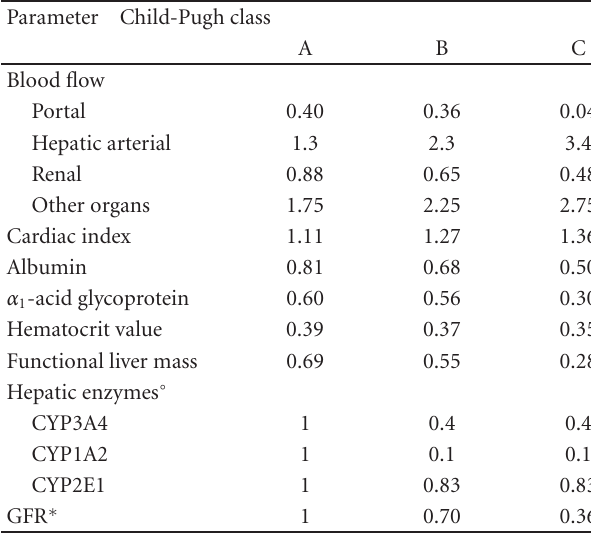
Table 1: Physiological changes associated with liver cirrhosis (Child-Pugh score A–C) presented as fraction of control values from healthy individuals. The table is adapted from Edginton and Willmann [34].